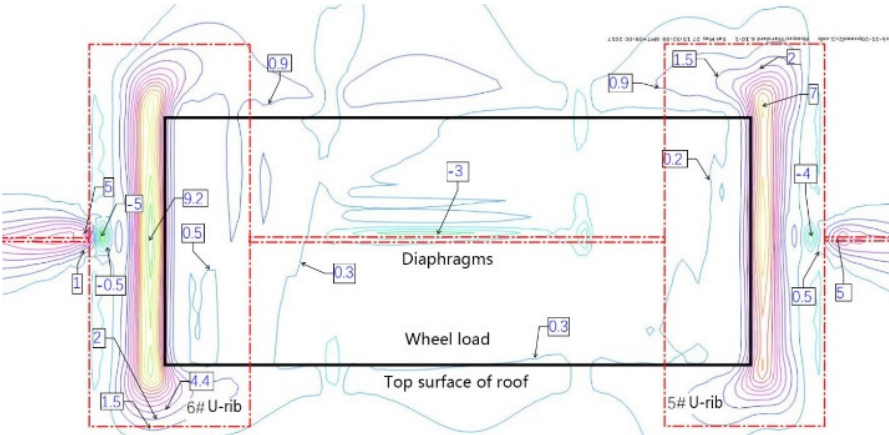
Figure 10. Contour of the principal stress of roof bottom at wheel trace (MPa).